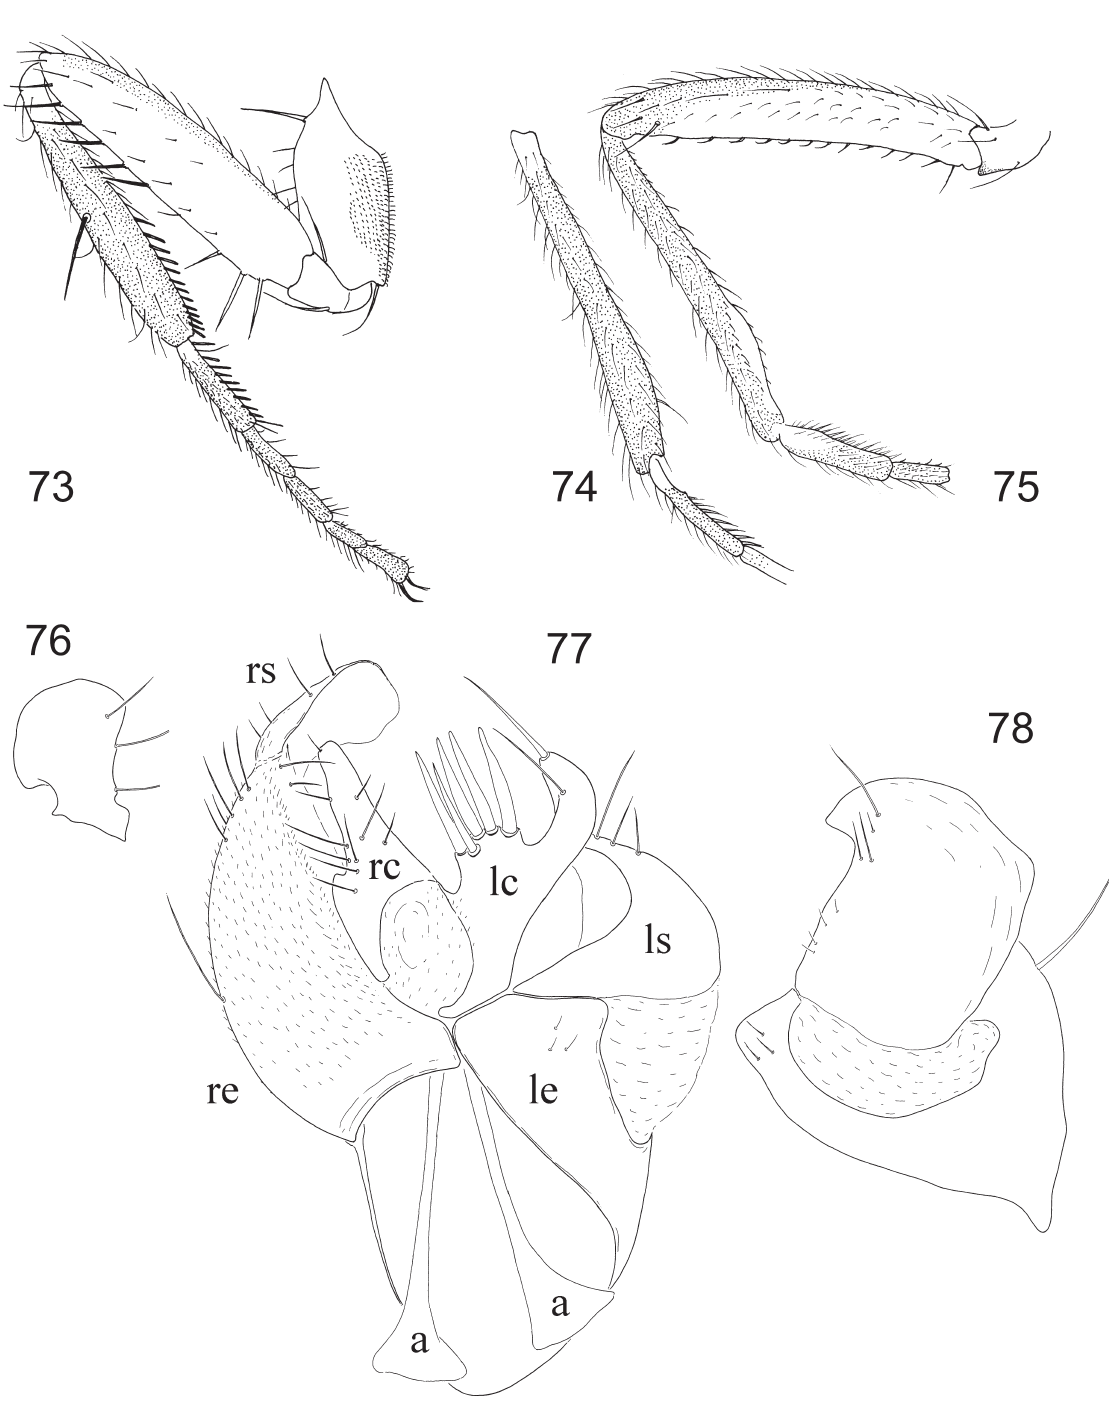
Figs 73-78. Pontodromia pantai sp. nov., ♂. 73 . fore leg, anterior view. 74 . mid tibia, anterior view. 75 . mid leg, posterior view. 76 . right surstylus, dorsal view. 77 . epandrium and cerci, dorsal view. 78 . left surstylus, lateral